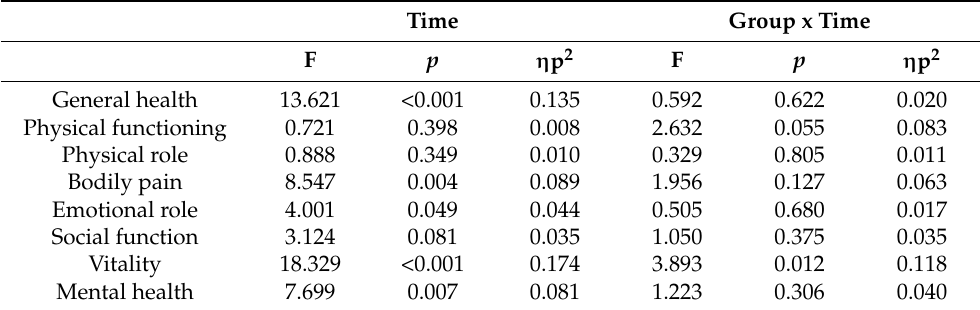
Table 8. Results of the ANOVA on SF-36.